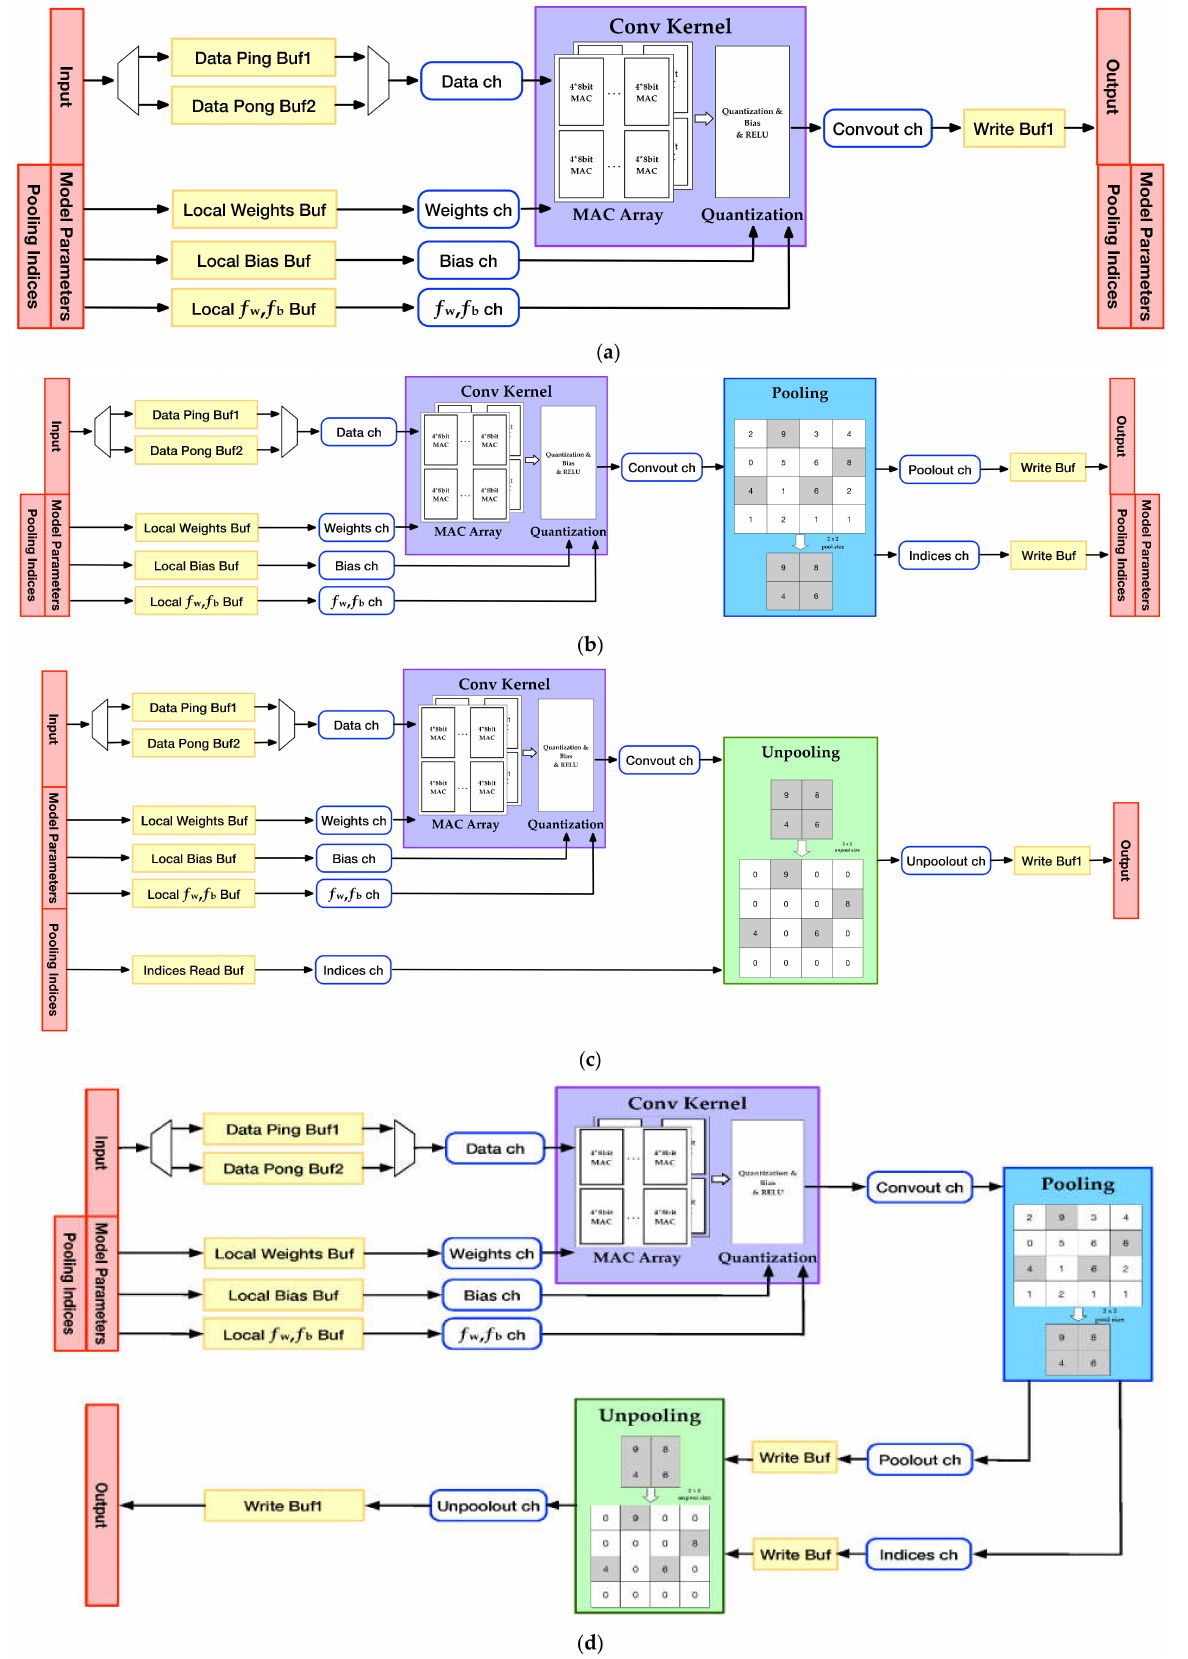
Figure 5. Four pipeline modes with configurable functions. ( a ) Mode 00: convolution; ( b ) Mode 01: convolution + pooling; ( c ) Mode 10: convolution + unpooling; ( d ) Mode 11: convolution + pooling +